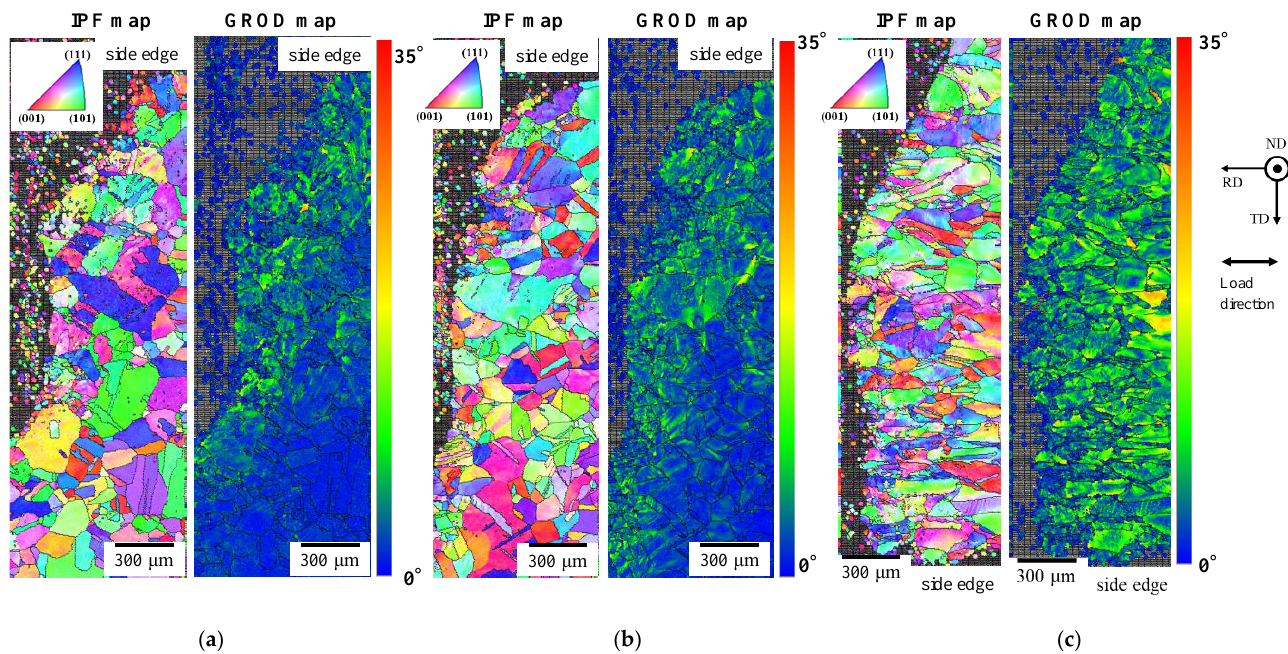
Figure 15. IPF maps and GROD maps of cross-sections of fractured areas of heat-treated specimens after low cycle fatigue test. ( a ) Stress amplitude: 50 MPa (fatigue cycle: 7,786,201 cycles); ( b ) stress amplitude: 75 MPa (fatigue cycle: 235,144 cycles); ( c ) stress amplitude: 100 MPa (fatigue cycle: 49,676 cycles).